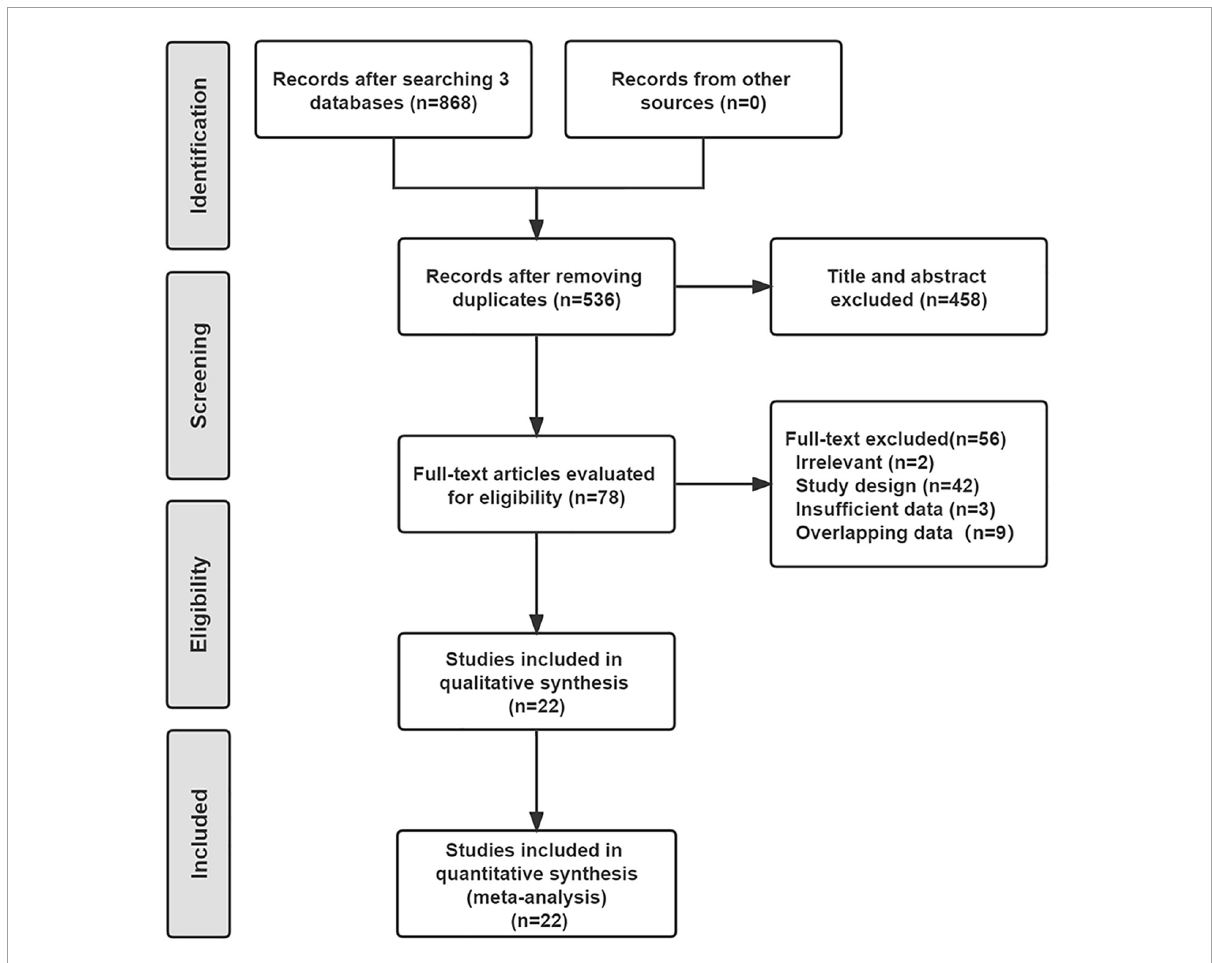
FIGURE1 Flow chart of the eligible